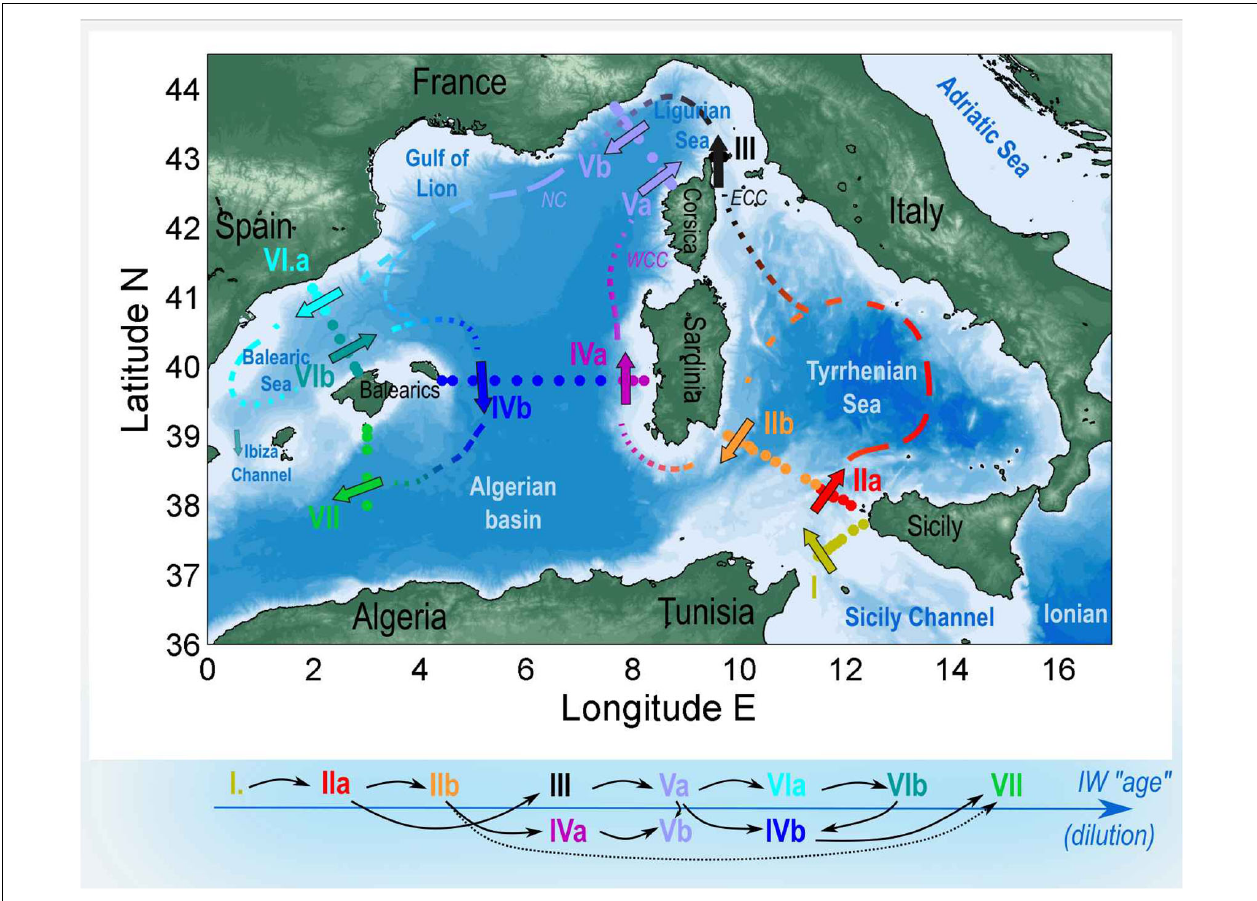
FIGURE 1 | Map of OC2015 cruise in August 2015, with a sketch of the IW path from the Sicily Channel to the interior of the western sub-basins. Colored areas and roman numbers (defined by physical data analysis and available literature) indicate the main path of IW in the